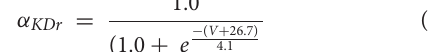
100 and 110mV, in 10mV increments. Current records are shown − + s.e.m. C m of 13 cells was 7.4 0.8 ± ±